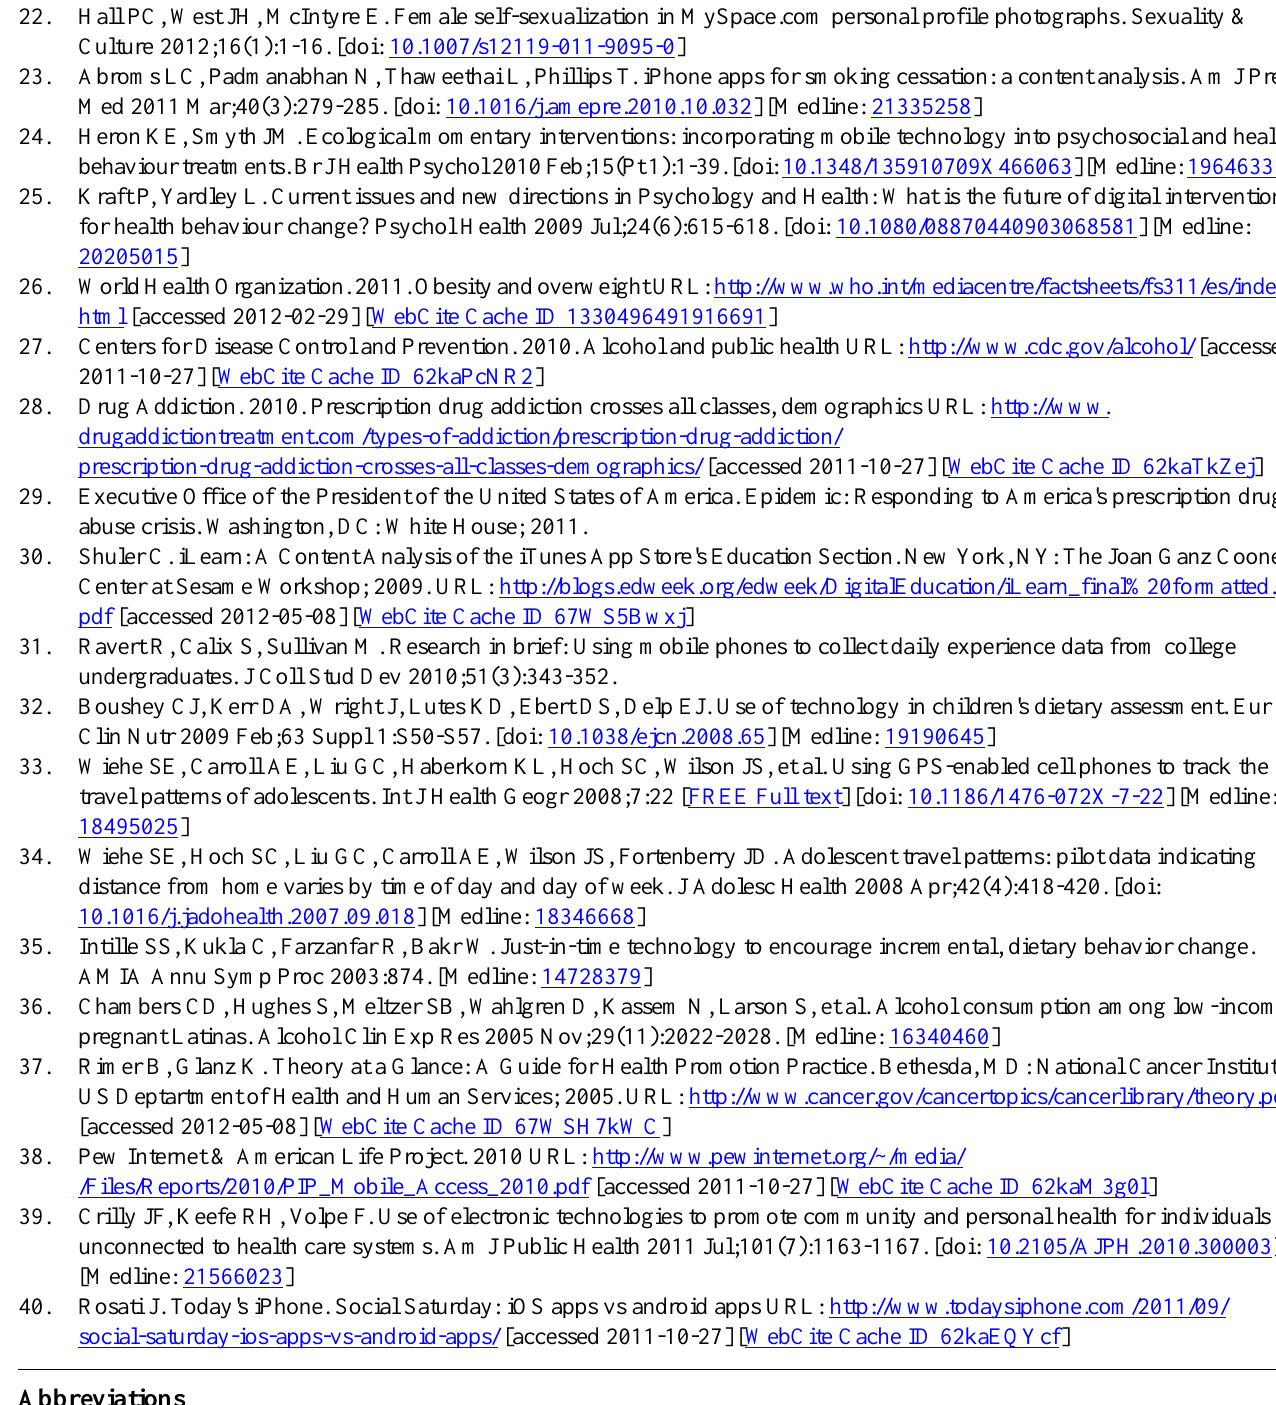
HECAT: Health Education Curriculum Analysis Tool PPM: Precede-Proceed